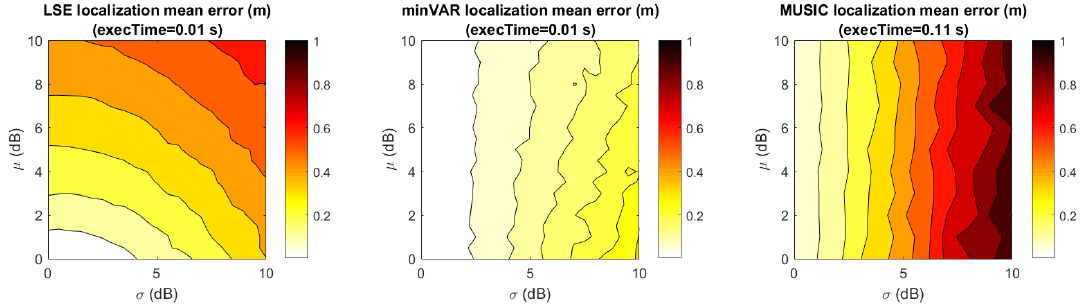
Figure 12. Simulated localization estimations with the Gaussian map bias (mean error).